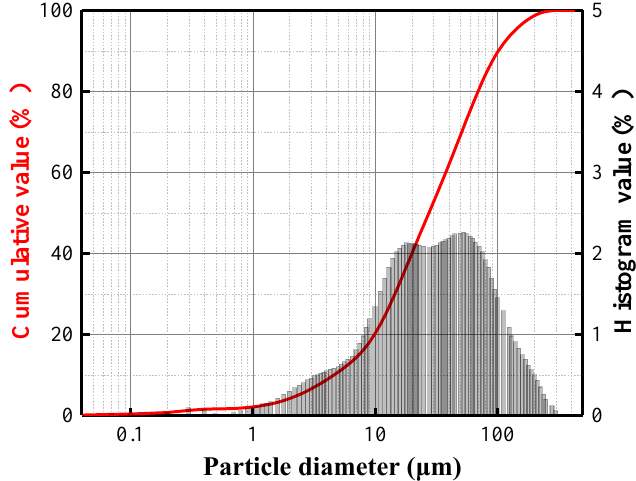
Figure 1. Particle size distribution of the BFA.